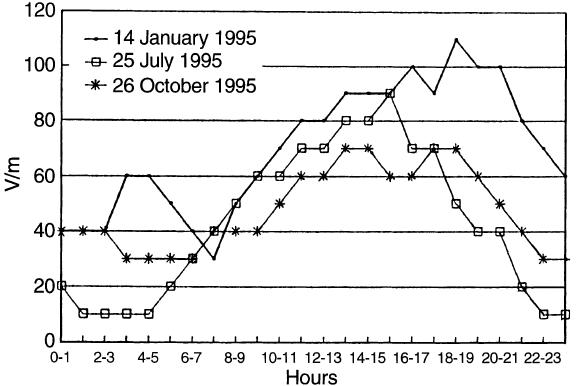
Fig. 6. Diurnal variation of the PG (in V/m) on fair-weather days in three di(cid:128)erent seasons: winter (January 14, 1995), summer (July 25, 1995) and autumn (October 26, 1995); hours mean UT here and in Figs.